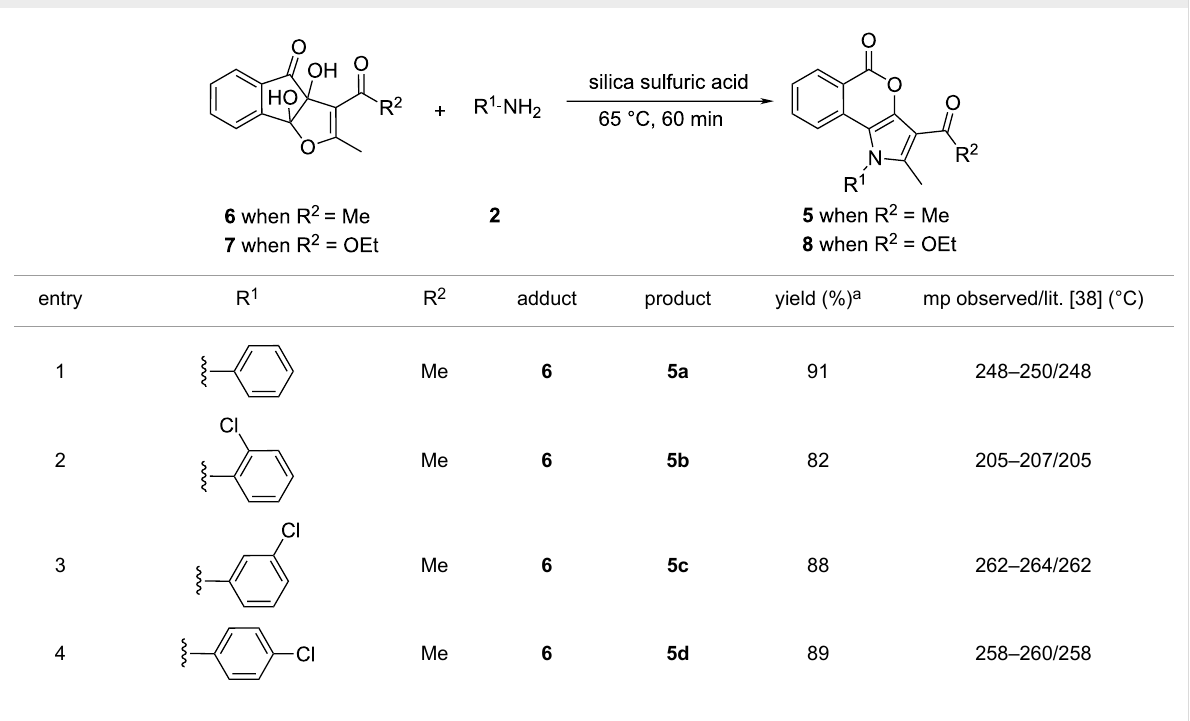
Table 2: Formation of isocoumarins 5 and 8 from adducts 6 and 7 respectively on an SSA surface.